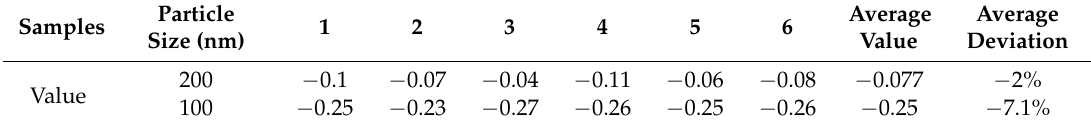
Figure 5. Apparent viscosity of the ZrO 2 feedstock versus shear rate at 180 °C .